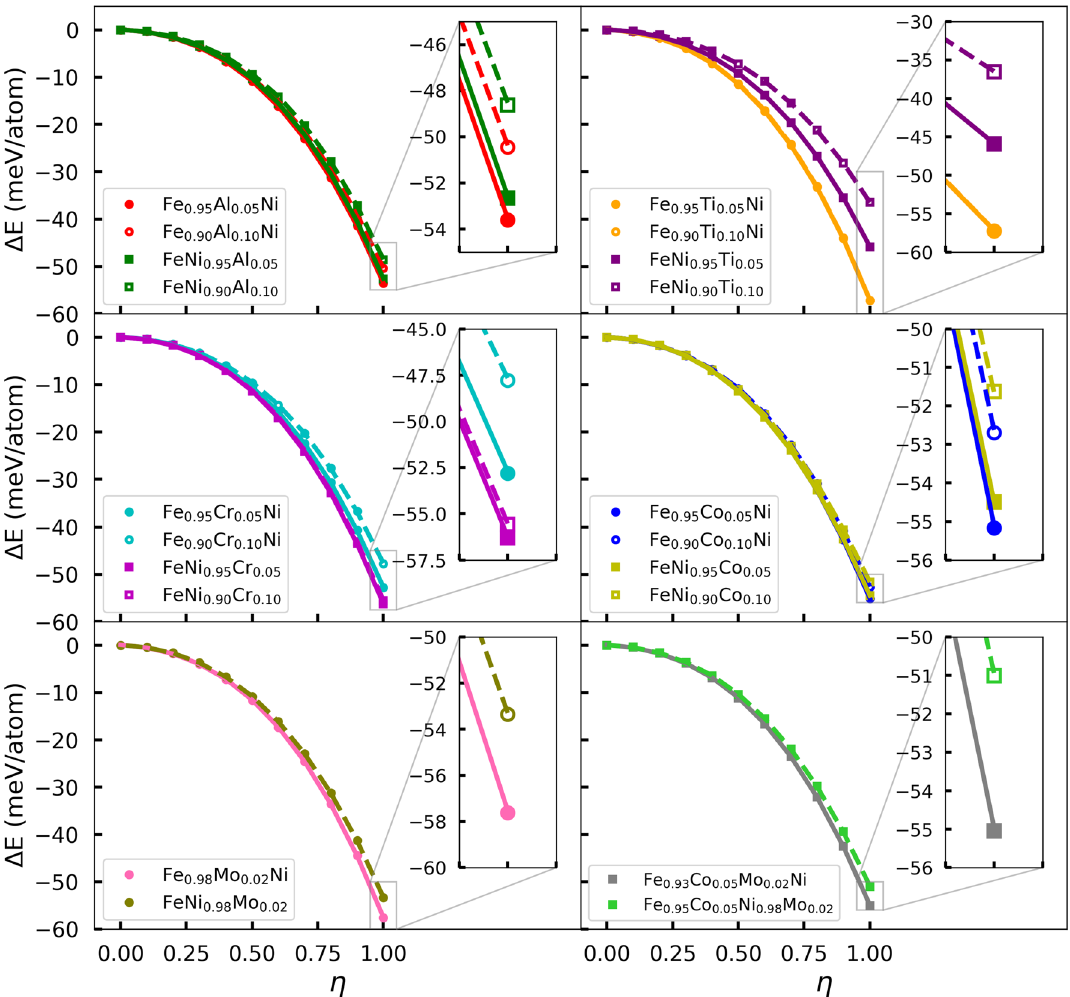
Figure 4. The energies of Fe 1 − x M x Ni and FeNi 1 − x M x ( M = Al , Ti, Cr, Co) relative to the energies of fully disordered phases, as well as Fe 0.98 Mo 0.02 Ni , FeNi 0.98 Mo 0.02 , Fe 0.93 Co 0.05 Mo 0.02 Ni and Fe 0.95 Co 0.05 Ni 0.98 Mo 0.02 as a function of order